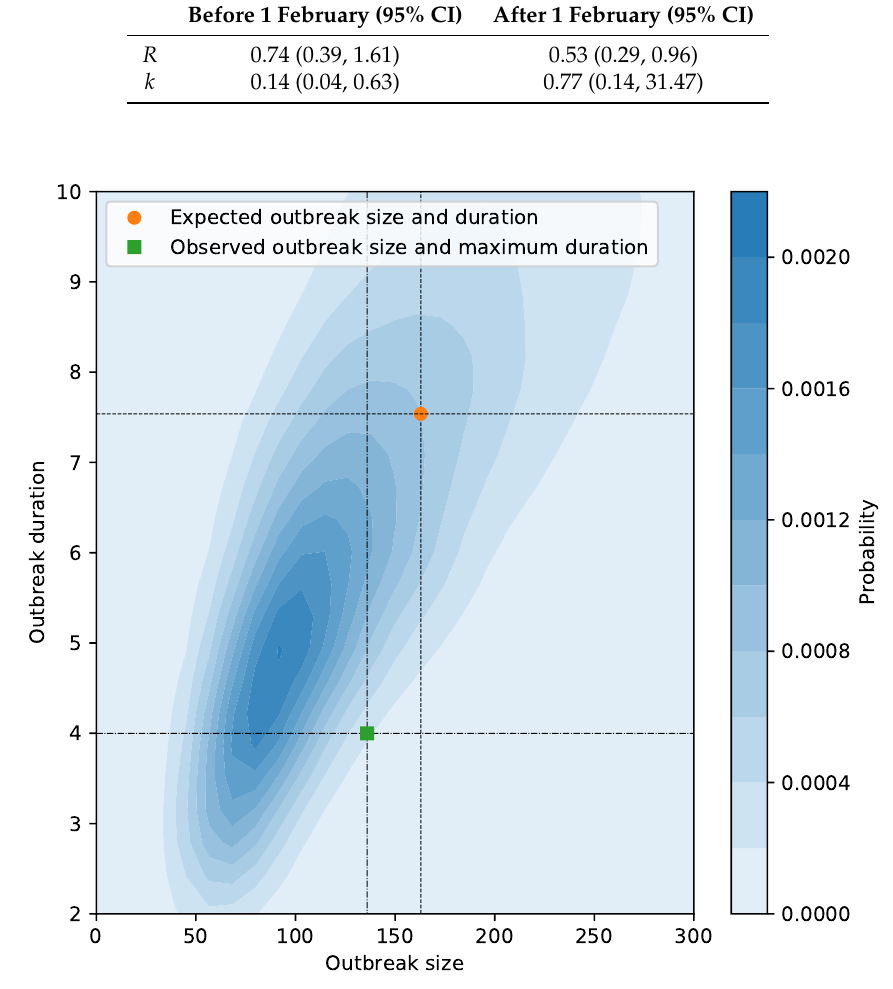
Figure 4. Simulated outbreak size and duration by assuming no control measures. Each simulation was started with 43 infections and based on reproductive number R = 0.74 and dispersion parameter k = 0.14, which were estimated from the data collected by 1 February 2020. The density and mean of duration and outbreak size were estimated based on 5000 Monte Carlo